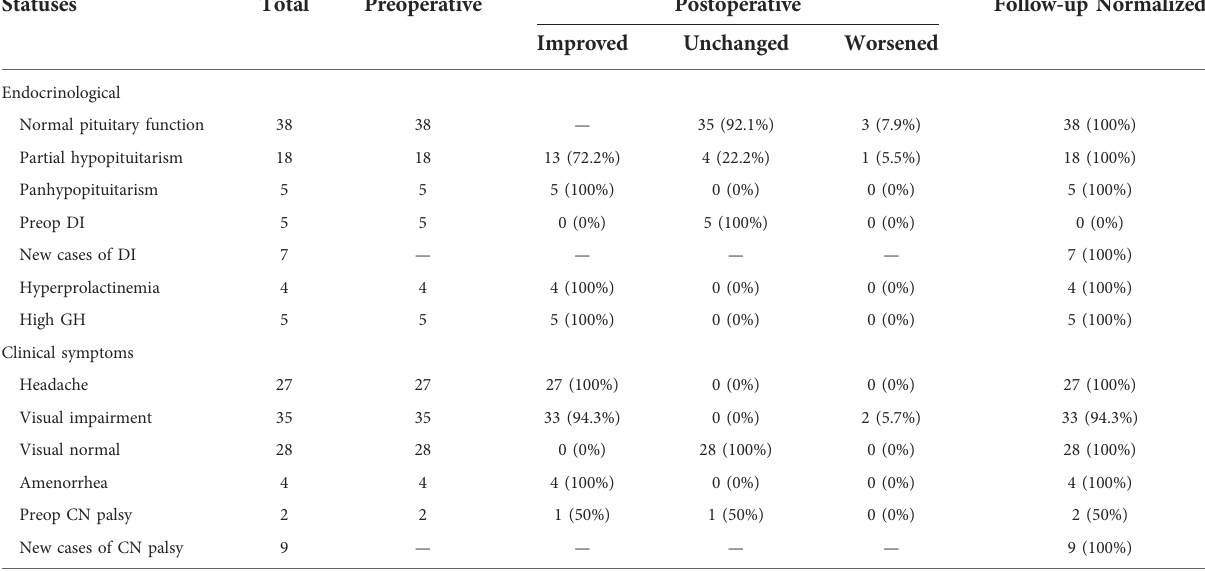
TABLE 3 Preoperative, postoperative, and follow-up statuses in all patients. Statuses Total Preoperative Postoperative Follow-up Normalized Improved Unchanged Worsened